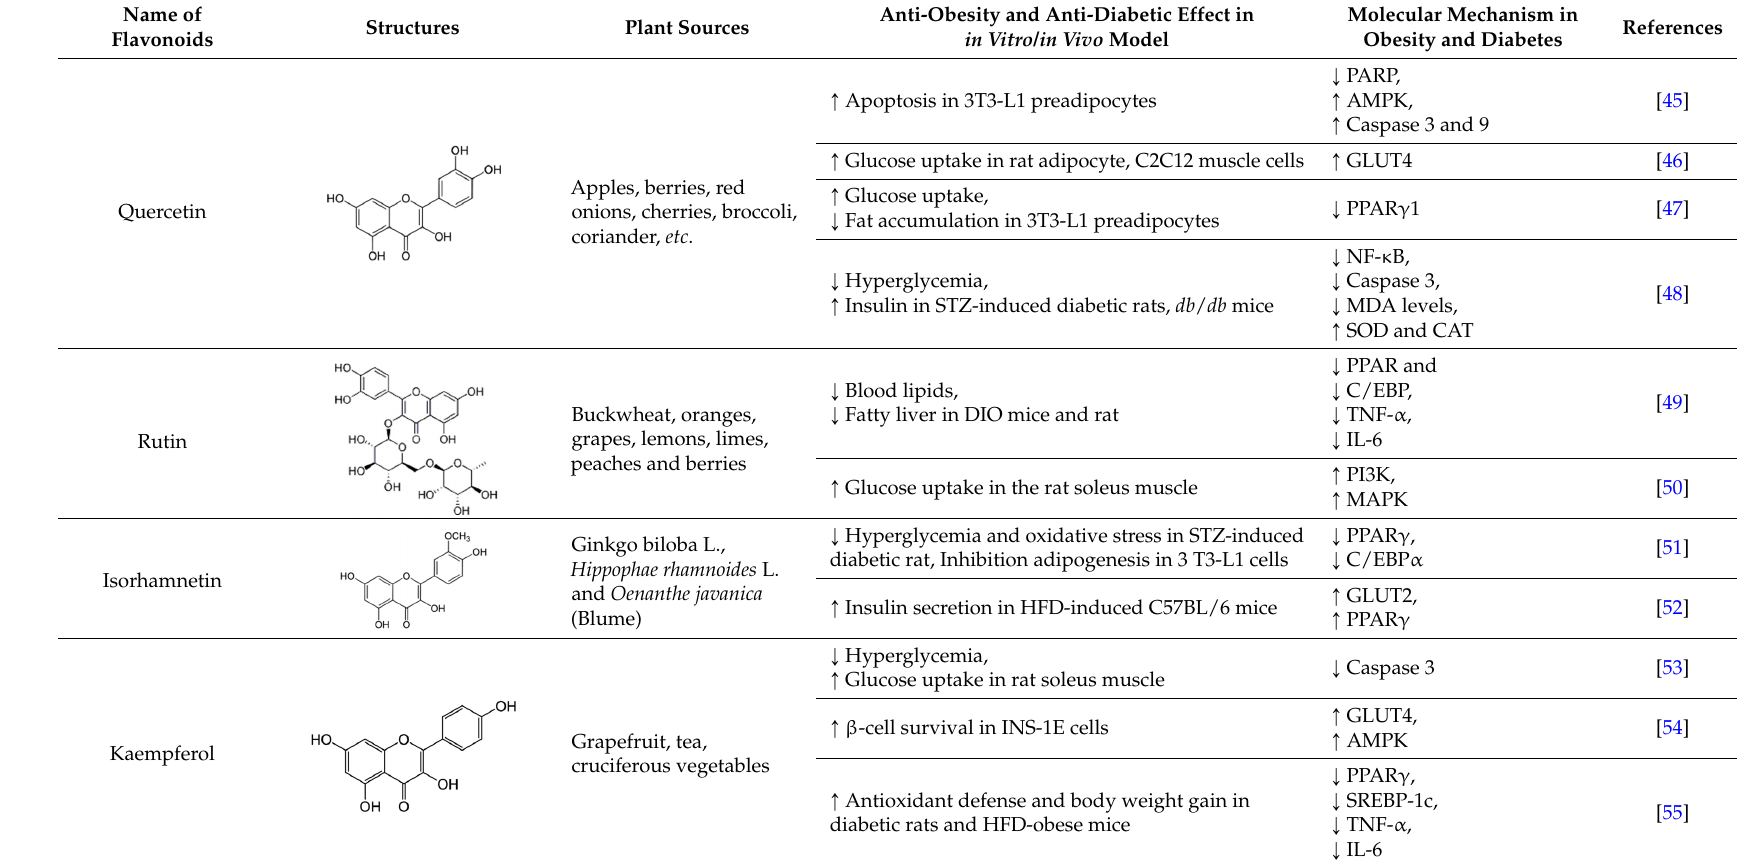
Table 1. Representative flavonoids showing anti-obesity and anti-diabetic effects.